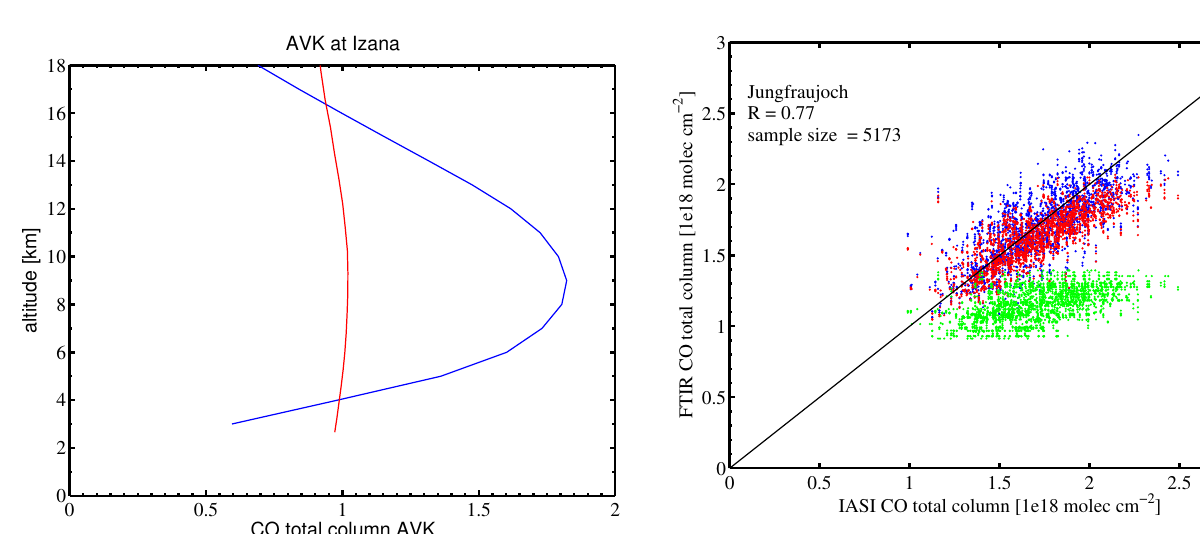
Fig. 4. FTIR CO total columns against the IASI CO for the un- corrected, unsmoothed columns (green), the altitude-adjusted (red) and altitude-adjusted, smoothed columns (blue) for Jungfraujoch. The correlation coefficient of the comparison between the altitude- adjusted, smoothed FTIR CO and IASI CO (blue) is shown. For clarity, only every second data point is